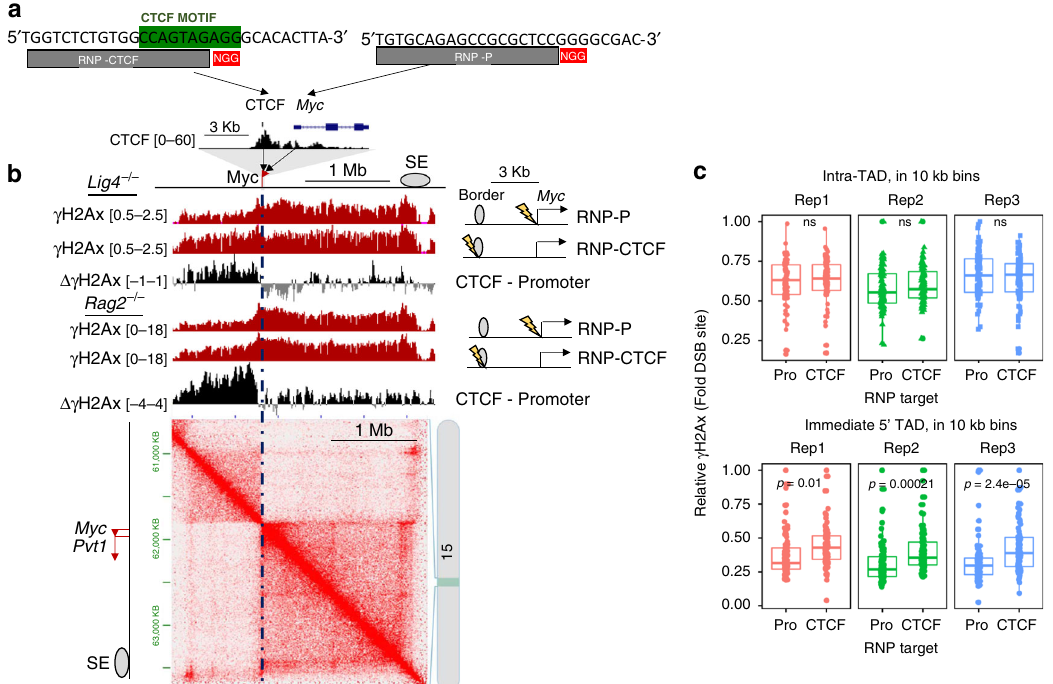
Fig. 5 DSBs at a CTCF motifs propagate γ H2Ax bidirectionally. a Guide target sequences and relative locations. Top: Genomic sequence of the upstream Myc -CTCF (RNP-CTCF) site or promoter (RNP-P) with target sites (gray with red NGG) and CTCF motif (green) labeled. Bottom: Zoom-in of the Myc promoter and 5 ′ CTCF region, which encompasses the TAD border. Black track shows CTCF binding (RPKM, n = 1). b γ H2Ax following DSBs targeted to the TAD border. Top: UCSC snapshot showing values for γ H2Ax CR-seq (red, RPKM, representative of three independent replicates) and V.4C (gray, interaction score, n = 2 merged independent replicates). Cartoons to the right of tracks show relative regulatory element and DSB sites (lightning bolts). γ H2Ax subtraction, labeled as Δ tracks (RNP-CTCF — RNP-P), show enrichment for the CTCF RNP in black and the promoter RNP in gray. Bottom: JuiceBox Browser representation of Hi-C data from Lig4 − / − cells for the Myc region ( n = 2, merged independent replicates). c γ H2Ax 2 h after 63 – 12 cells were nucleofected with RNP- Myc -P or RNP-CTCF, quanti fi ed in 10 kb bins across either the Myc -containing TAD or immediate 5 ′ TAD. Each γ H2Ax dataset was fi rst normalized to RPKM values at the DSB-containing bin. Colors represent independent replicates. Statistical enrichment (two-sided Paired Student ’ s t test) is shown above (ns non-signi fi cant). Means, quartiles, and outlier limits (1.5 × interquartile range) are indicated by the median line, box and whiskers,